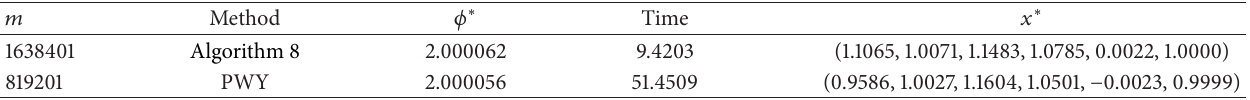
Table 1: Test results for Example 1.